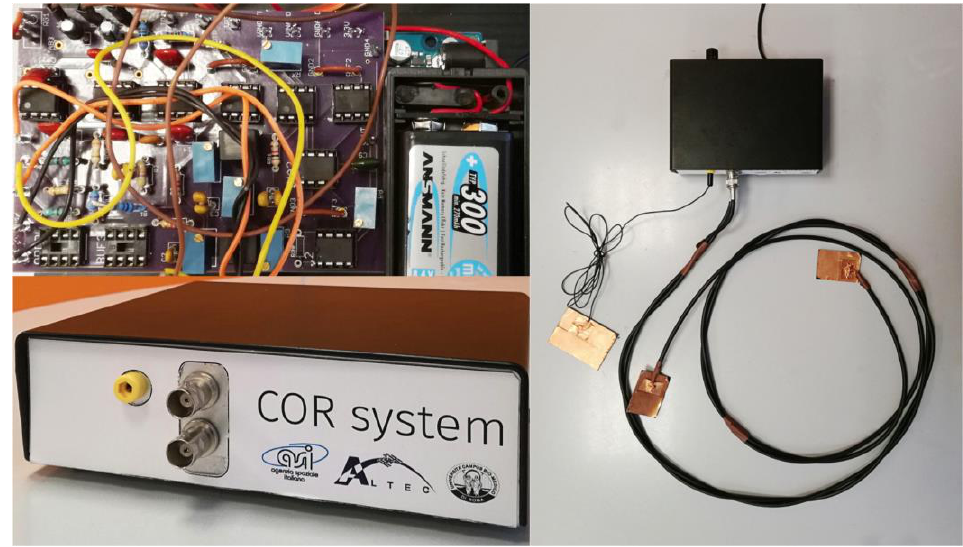
Figure 9. System overview (the box containing the electronic board, the electronic board, the three electrodes connected to the system).